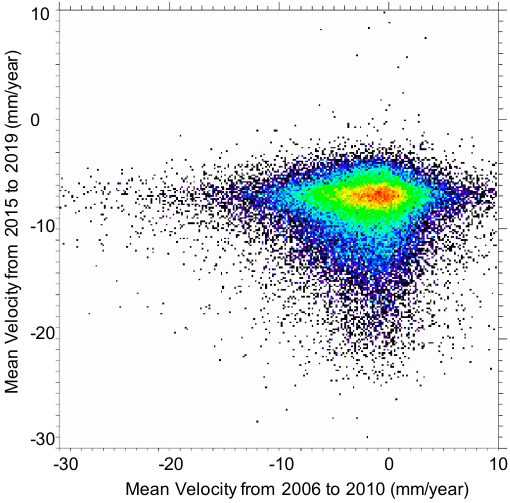
Figure 10. Comparison between the mean displacement velocity from 2015 to 2019, derived from PALSAR-2 data, and from 2006 to 2010, derived from PALSAR data.